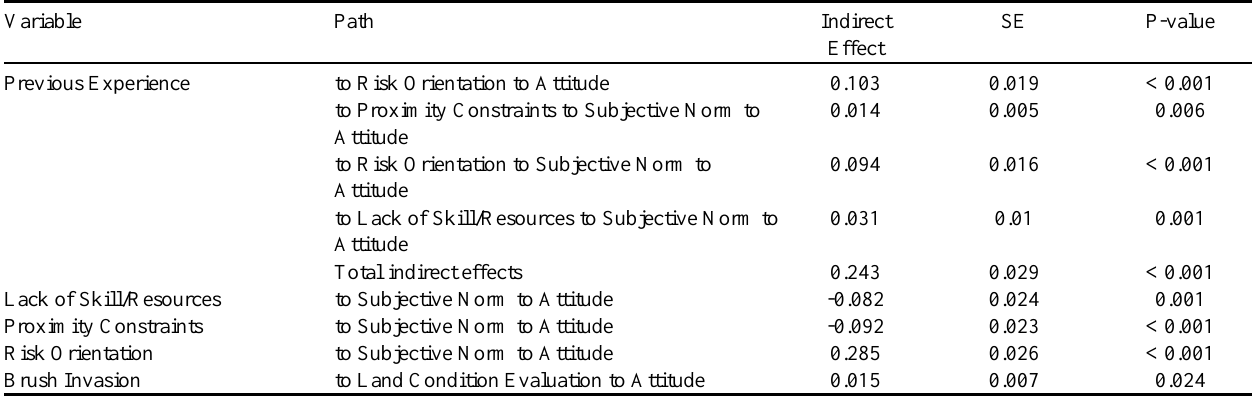
Table 2 . Indirect effects of items on attitude toward high-intensity prescribed